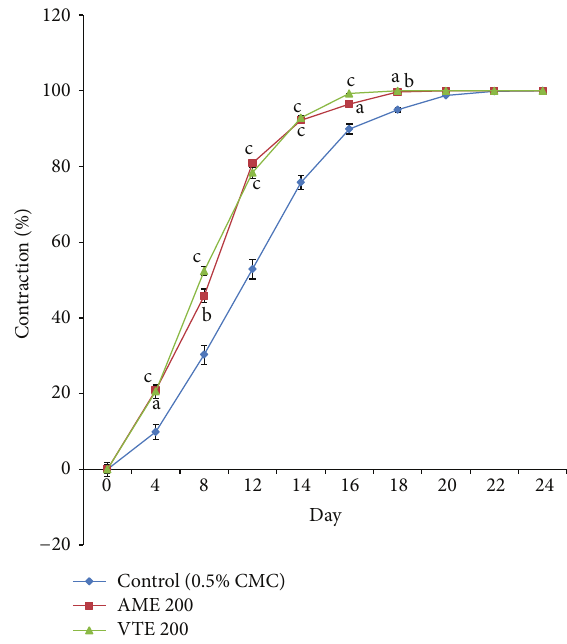
Figure 1: Effect of AME and VTE on percent wound contraction in excision wound. Range of 0 day wound area of control, AME, and VTE group (409.6 ± 17.9 to 418.0 ± 21.0 mm 2 ). Results are mean ± SEMpercentwoundcontractionfromrespective0dayvalue( 𝑛 = 6 ). a 𝑃 < 0.05 , b 𝑃 < 0.01, and c 𝑃 < 0.001 compared to respective day control group (statistical analysis was done by one-way analysis of variance followed by Dunnett’s test for multiple